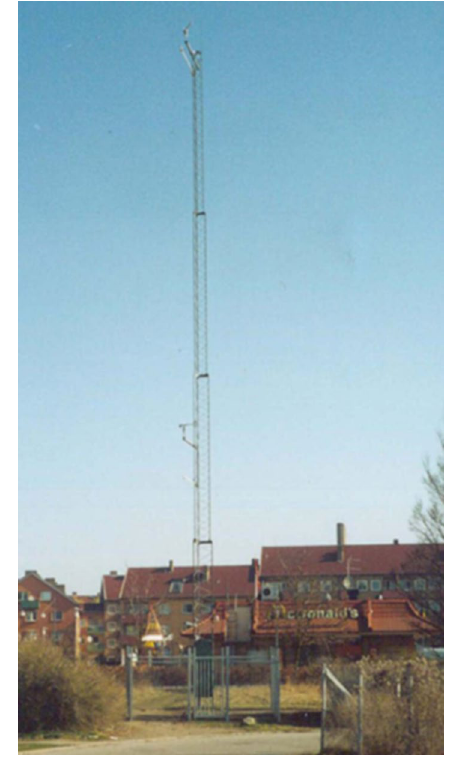
Fig. 3 Heleneholm meteorological monitoring station in